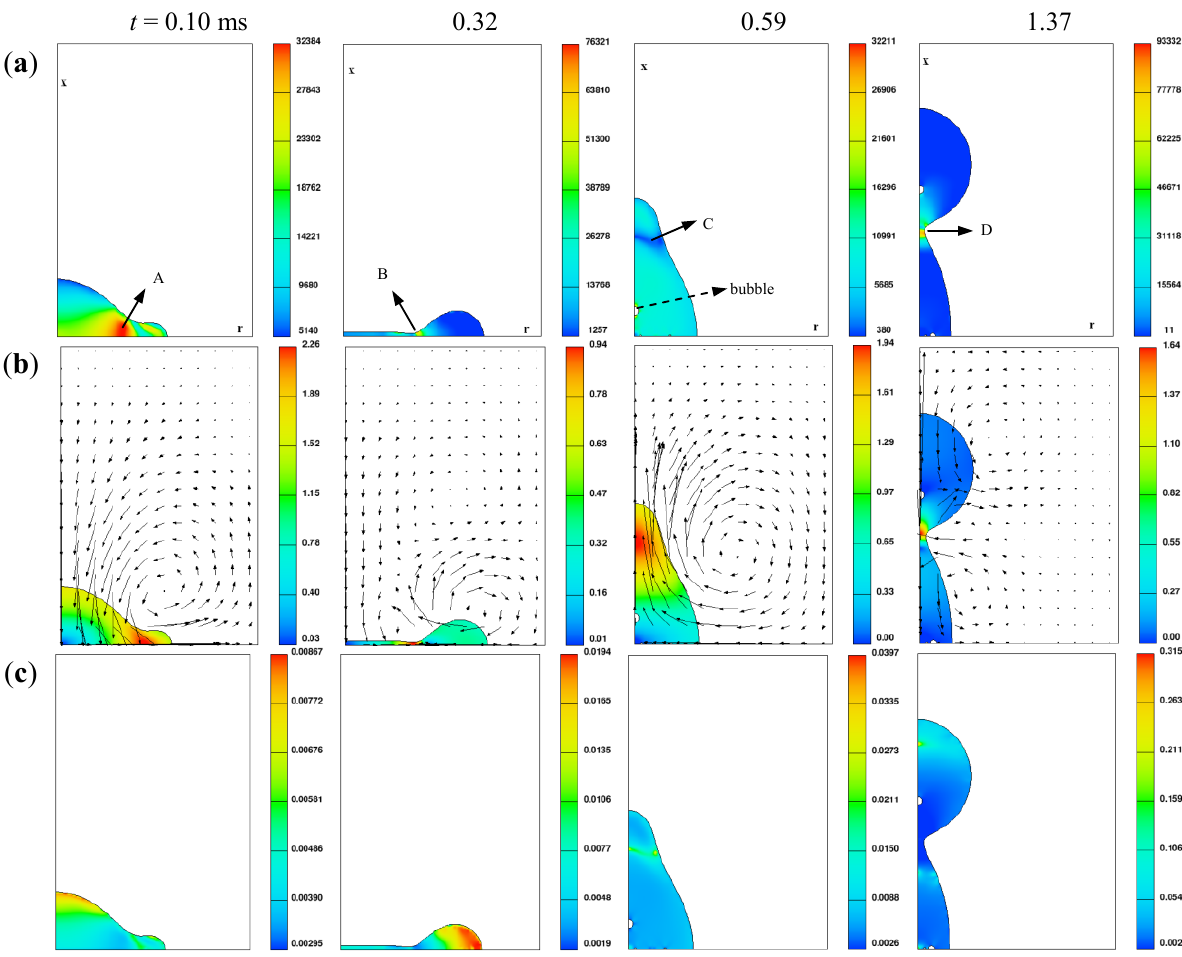
Figure 11. ( a ) Shear rate (s − 1 ), ( b ) velocity (m·s − 1 ) and ( c ) dynamic viscosity (Pa·s) field evolution for reflexive separation